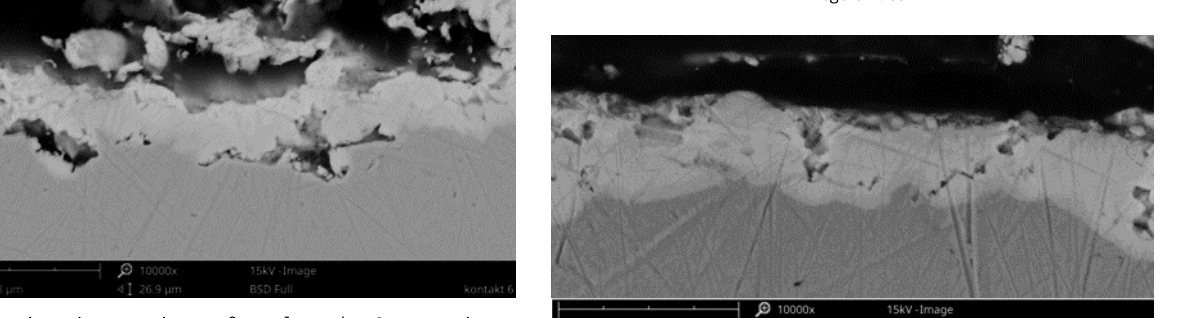
Fig. 4. Scanning microscope image of sample number 3 – a continuous layer, uneven coating thickness, visible delamination